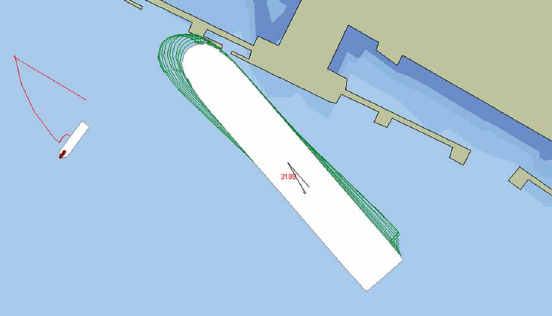
Fig. 8. PANAMAX tanker assisted by one tug and leaving the berth